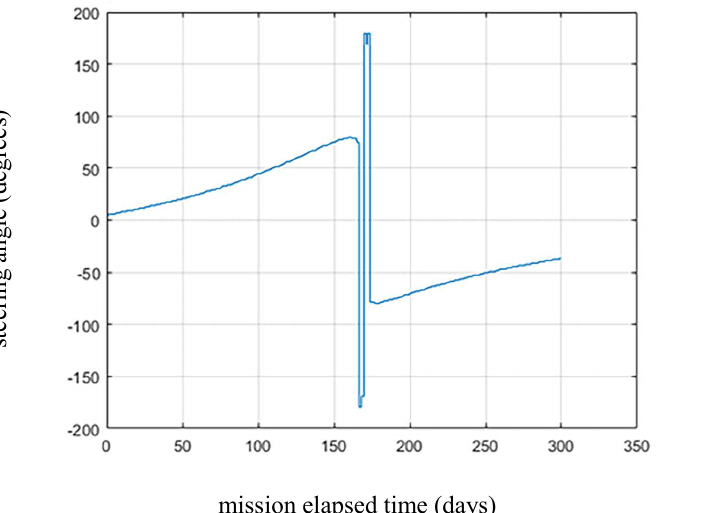
Figure 8. Steering angle (deg) for the mission profile in Figure 7. The horizontal axis is transfer time (in